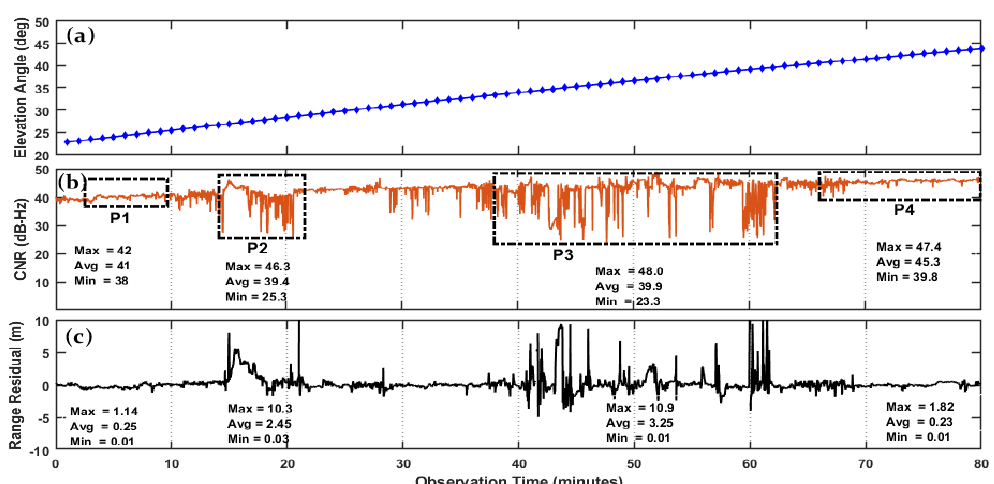
Figure 4. The satellite signal quality assessment of GNSS set to quad-constellation mode in different types of environments denoted by P1, P2, P3 and P4 in Sukkur city. ( a ) Elevation angle, ( b ) Carrier-to- Noise Ratio (CNR) and ( c ) Range